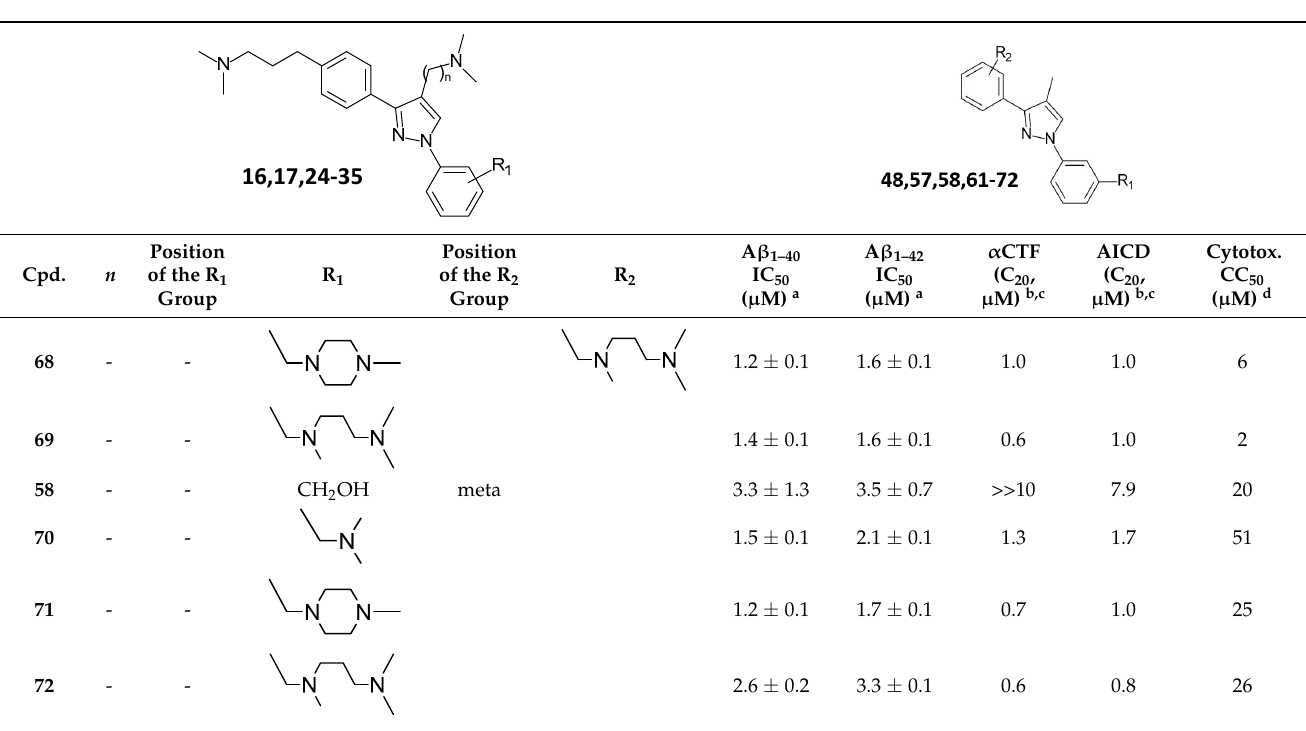
Table 1. Effects of compounds 24 – 35 , 61 – 72 on the metabolism of APP.